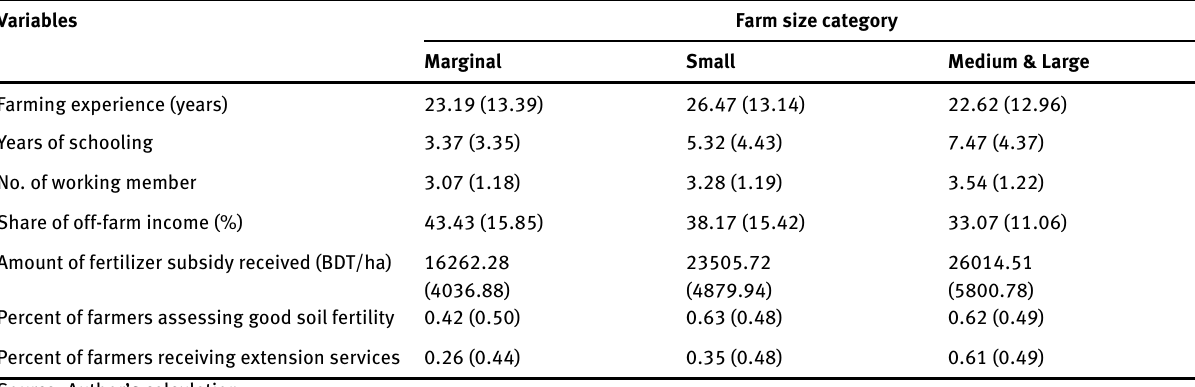
Table 1: Summary statistics of explanatory variables in economic inefficiency model